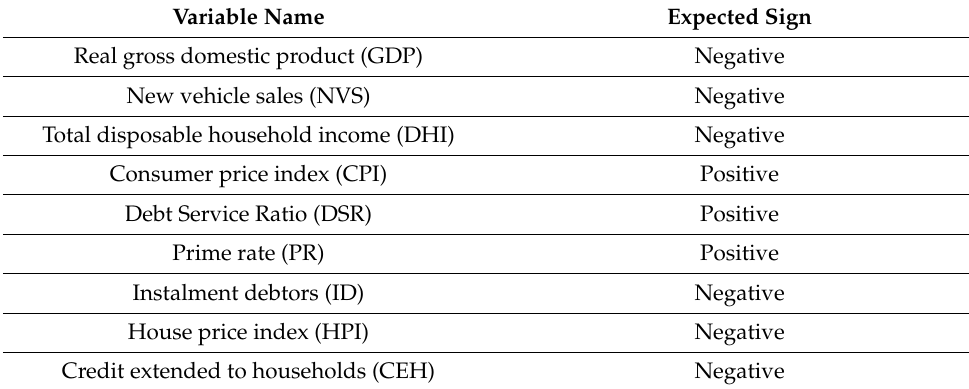
Table 3. Expected regression coefficient ( ˆ β c κ ) signs.